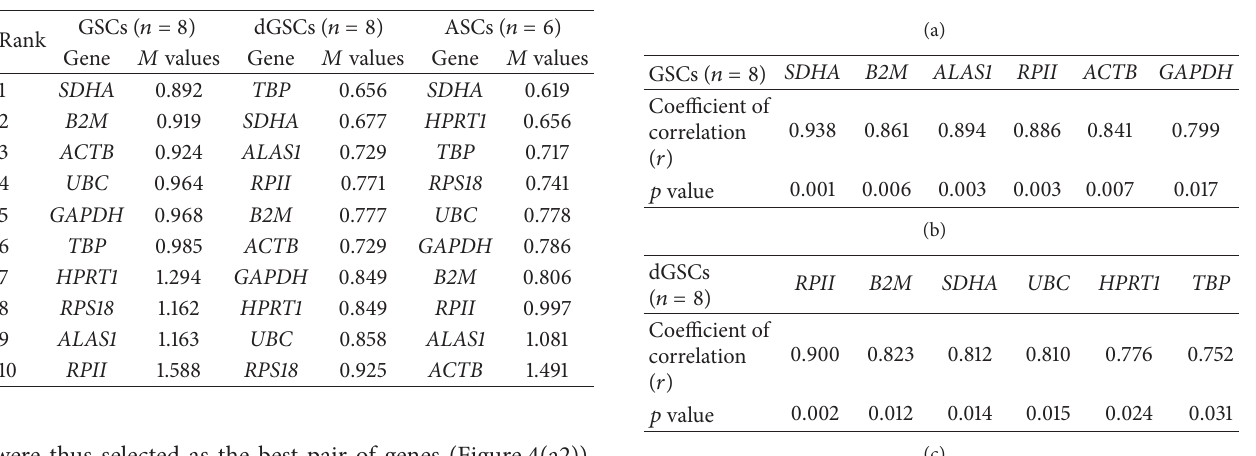
Table 4: GeNorm analysis. Table 5: BestKeeper correlation